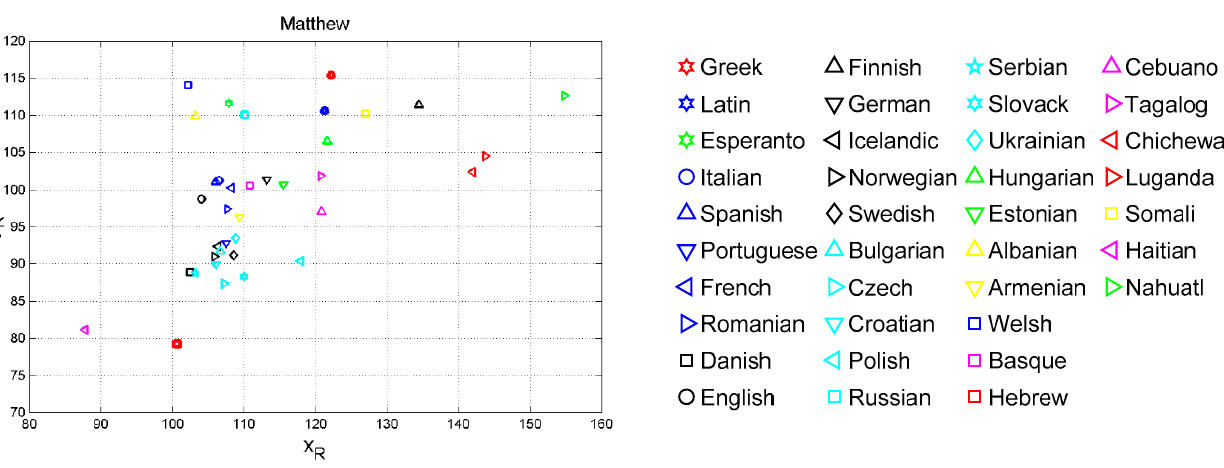
Figure 2. ( Left panel ): Vector plane x R and y R of all languages concerning Matthew; for Greek x R ≈ 121; y R ≈ 115. ( Right panel ): Graphical symbols referring to the indicated languages.